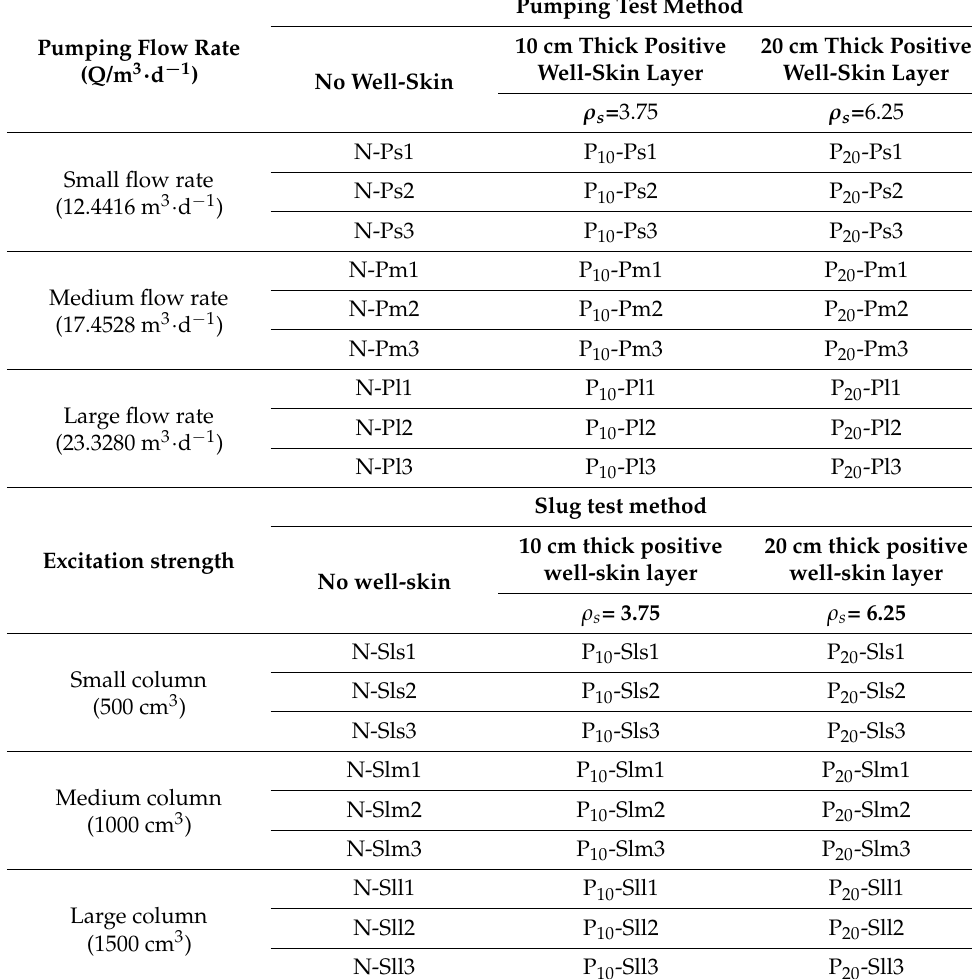
Table 1. Table of test numbers.